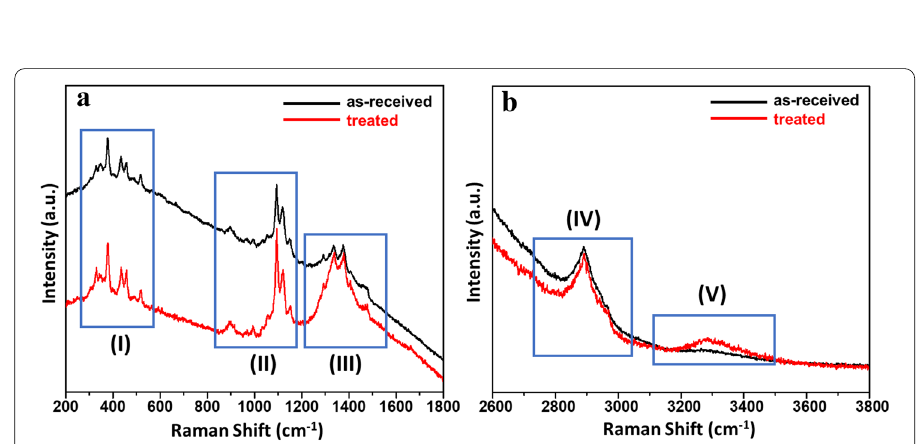
Fig. 3 Raman Spectra of as‑received and thermochemically treated muslin sample ( a ) 200–1800 cm − 1 regions ( b ) 2600–3800 cm − 1 regions. No Raman peaks were observed between 1800 cm − 1 and 2600 cm −